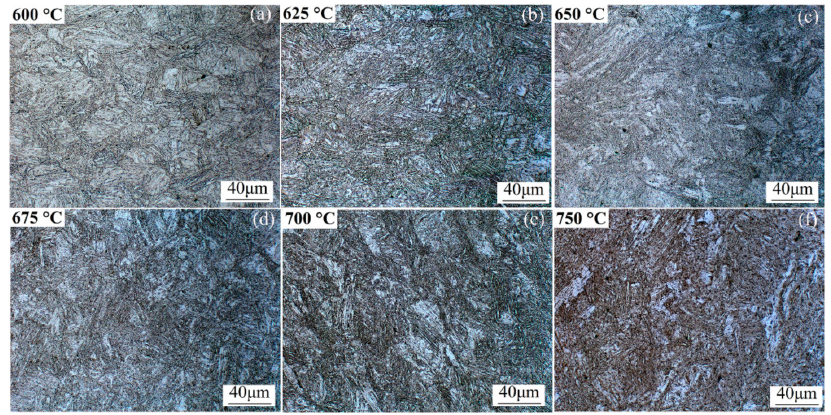
Figure 3. Optical micrographs of experimental steels at different annealing temperatures. ( a ) 600 ◦ C,